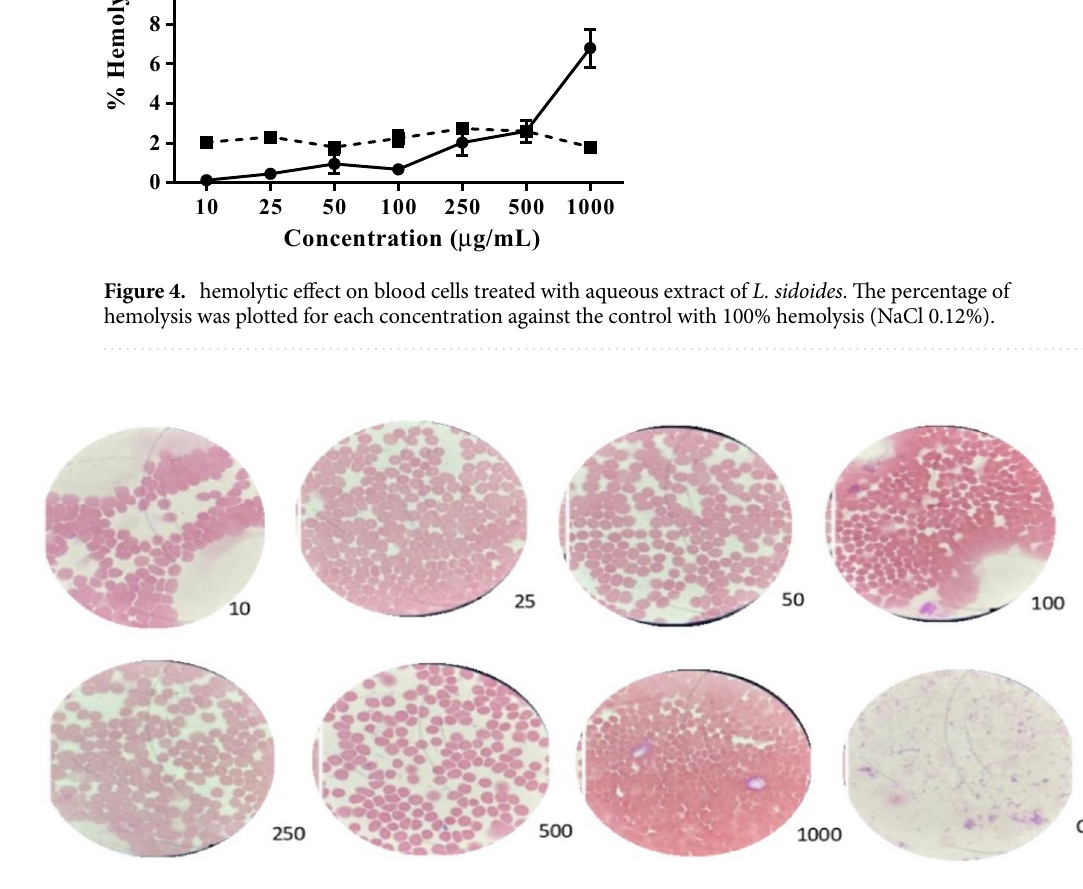
Figure 5. Comparison of erythrocyte morphology treated with different concentrations of L. sidoides aqueous extract and positive control (C + ) with distilled